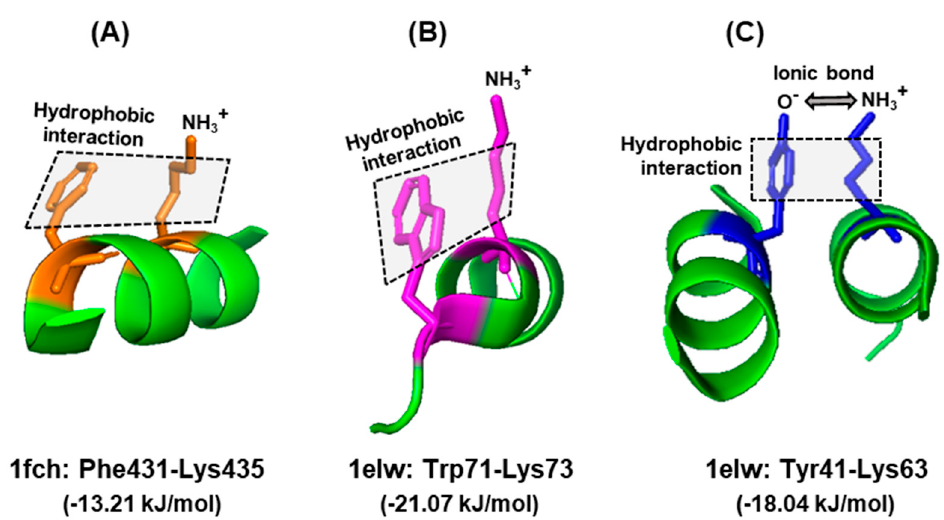
Figure 4. Interactions of aromatic side chains. Example of similarity and distinction among the three aromatic amino acids. In all three examples, the hydrophobic aromatic parts of the side chains of Phe ( A ), Trp ( B ), and Tyr ( C ) are engaged in hydrophobic interaction with the hydrocarbon part of Lys. In case of Tyr, the acidic (oxyanion, O − ) terminus additionally forms an ionic bond with the amino terminus of Lys side chain (NH 3 + ), since they are negatively and positively charged, respectively, at physiological pH. The hydrophobic interaction is denoted by shaded rectangles. Other, interconnecting interactions are not shown for clarity; for example, the positively charged amino group of Lys435, which appears to be free in this diagram, is actually engaged in ionic interactions with the negatively charged carboxylic acid group of Glu232 (not shown), brought to proximity due to folding of the polypeptide. The amino acids in each interacting pair are indicated with the same color. The structures were obtained from the PDB entries written below, along with the corresponding energy of stabilizing interaction, as described in Section 6.1. Only the relevant portions of the proteins are shown as a ribbon diagram in the PyMol presentation.